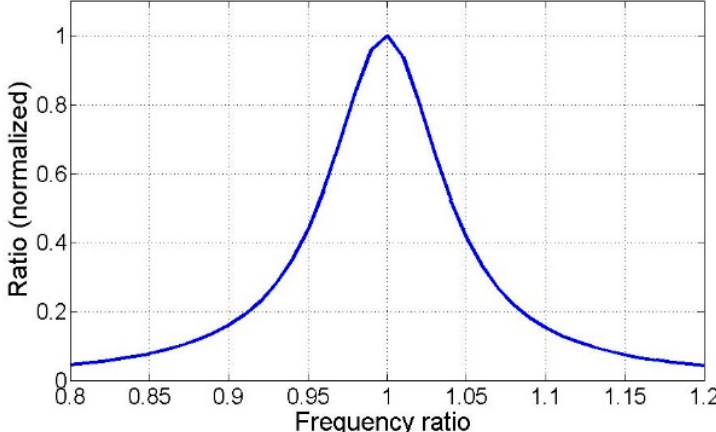
Figure 1. Covariance ratio: The graph was given by normalization from theory. If the difference between vibration mode and acoustic mode was larger, the frequency ratio became larger numerically.